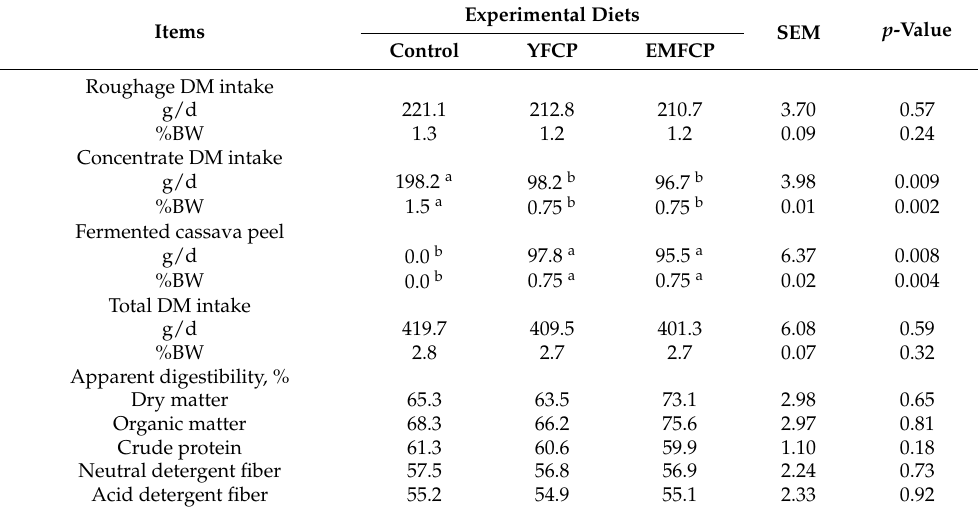
Table 3. Feed intake and the apparent digestibility of the experimental diets in